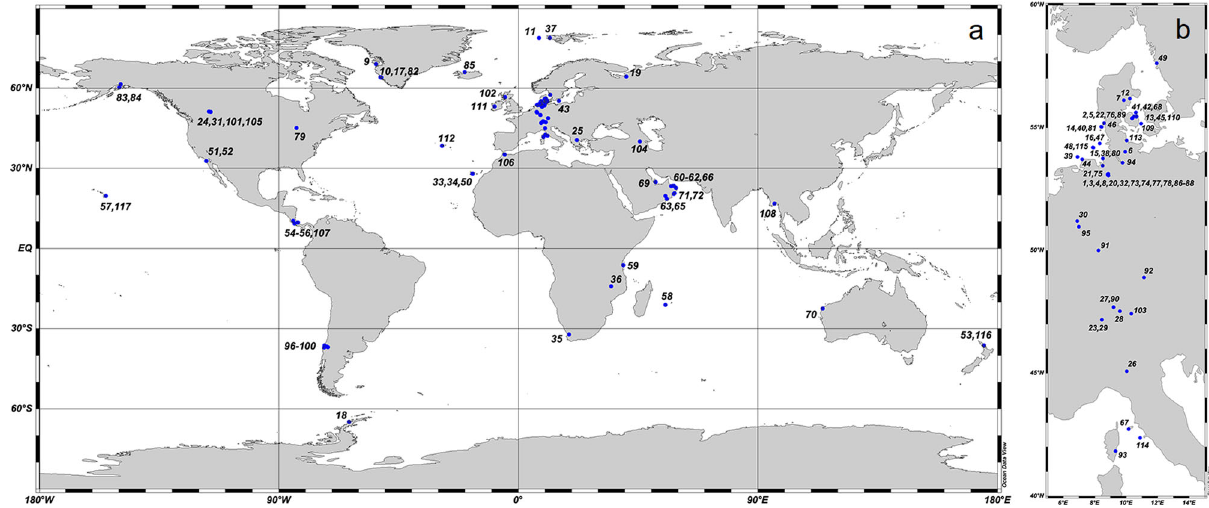
Fig. 1 Map of sampling sites. a Global and b Central European distribution of 117 sampling sites (numbered blue circles) at which the occurrence and the determinants of intracellular nitrate were studied. The map was created using the software package ODV 5.6.1 (Schlitzer, Reiner, Ocean Data View, odv.awi.de, 2021). Sampling details are given in Supplementary Table 1 (Supplementary Data 1) and in an interactive map created using Google My Maps (https://bit.ly/2XF9kkQ).